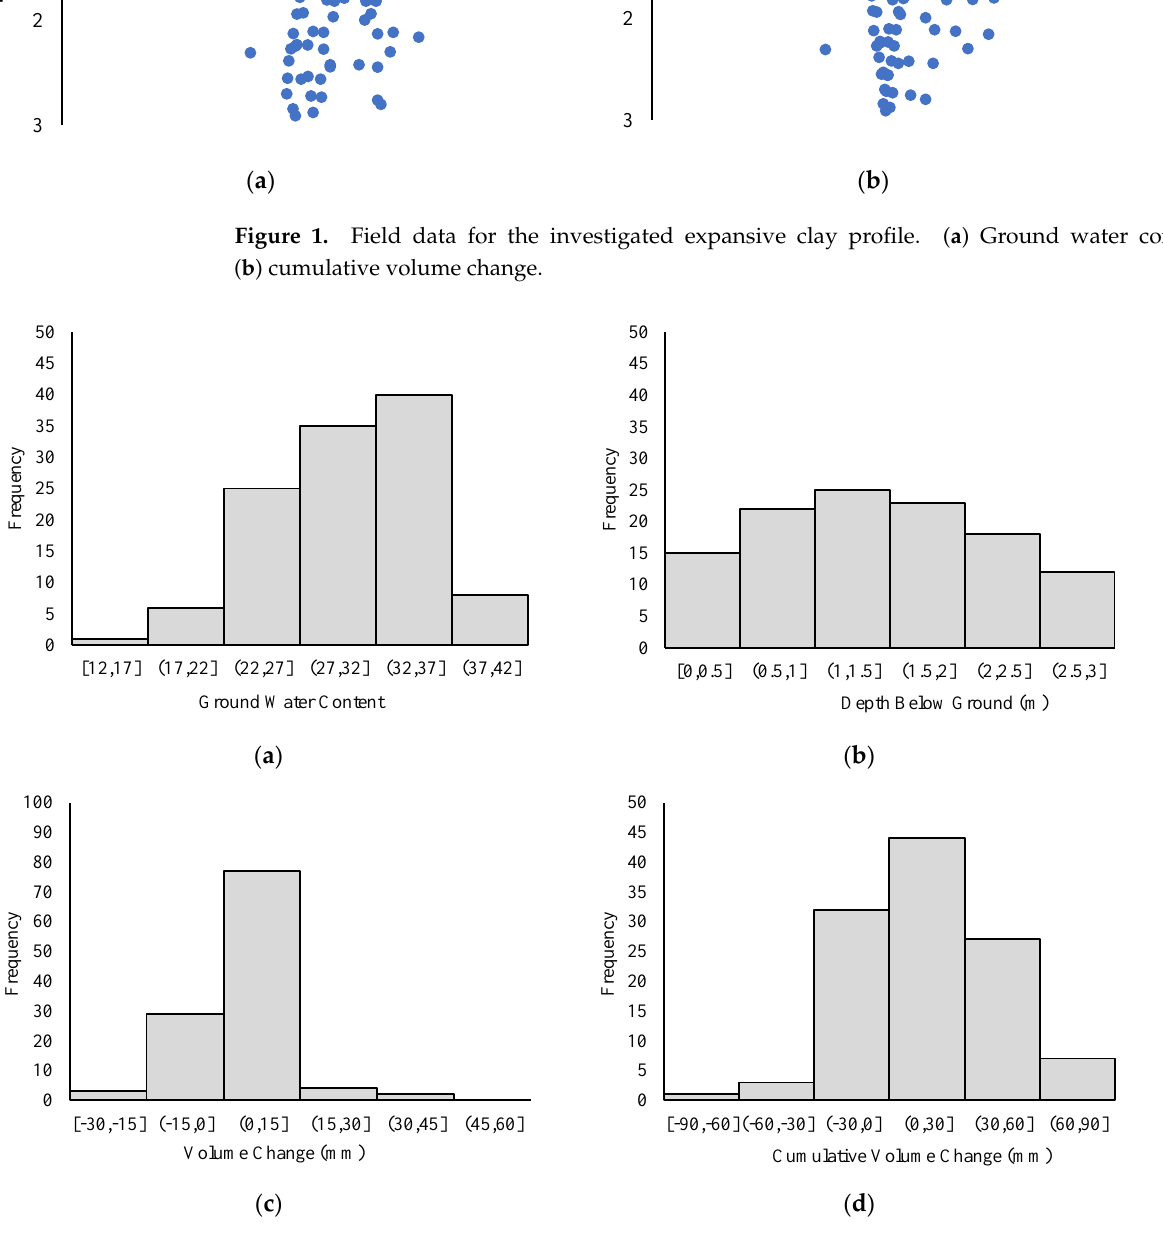
Figure 2. Histograms of field data for the investigated expansive clay. ( a ) Ground water content, ( b ) depth below ground, ( c ) volume change, ( d ) cumulative volume